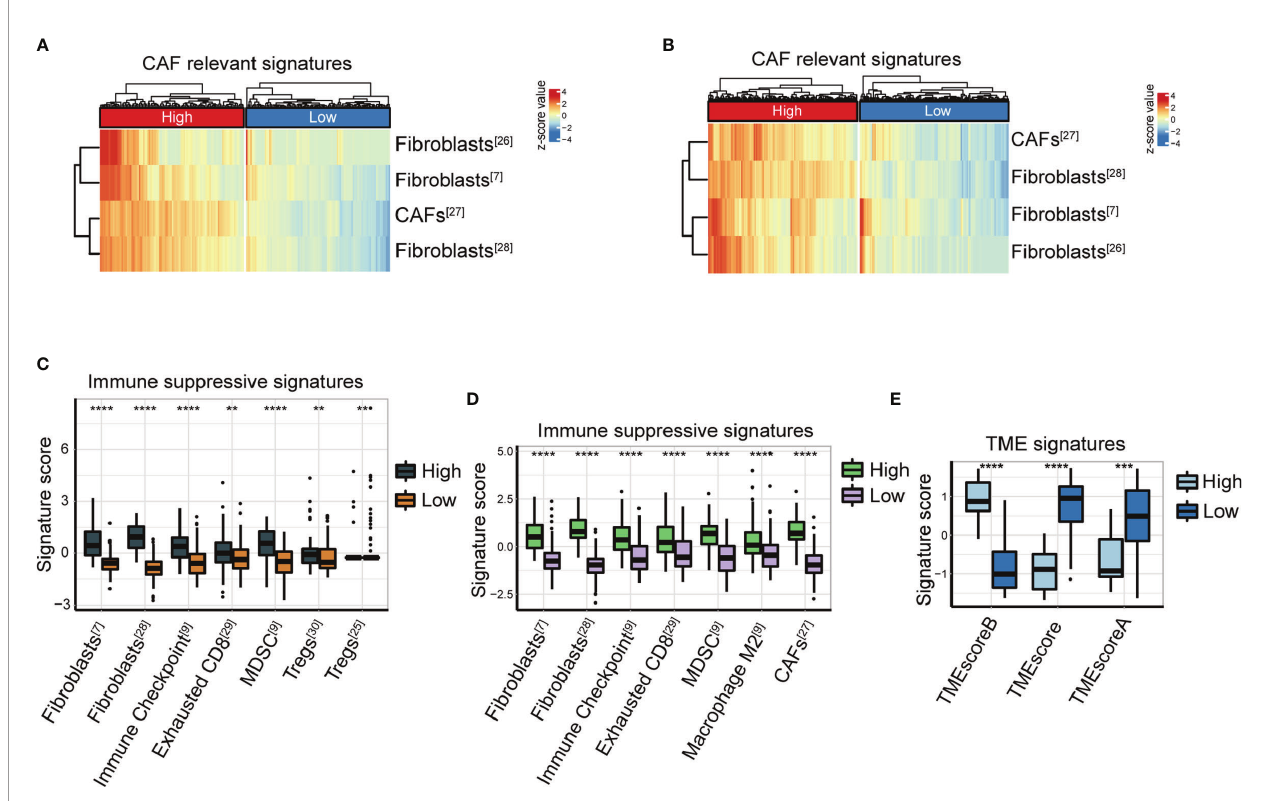
FIGURE 2 | FAPexpressioniscloselycorrelatedwithimmunosuppressivesignatures. (A, B) HeatmapofCAF-relevantsignatures(7,28 – 30) inthe highor lowFAPgroupfrom theACRG cohort (A) andTCGA-STADcohort (B) . (C, D) Immunesuppressivesignaturescore (7, 26 – 31)oftwoclustersdistinguishedaccordingtoFAPexpressioninthe ACRG cohort (C) andTCGA-STADcohort (D).(E) TMEsignaturescorebetweenhighandlowFAPgroupsinthe Nanostringcohort.** p <0.01; *** p < 0.001; **** p